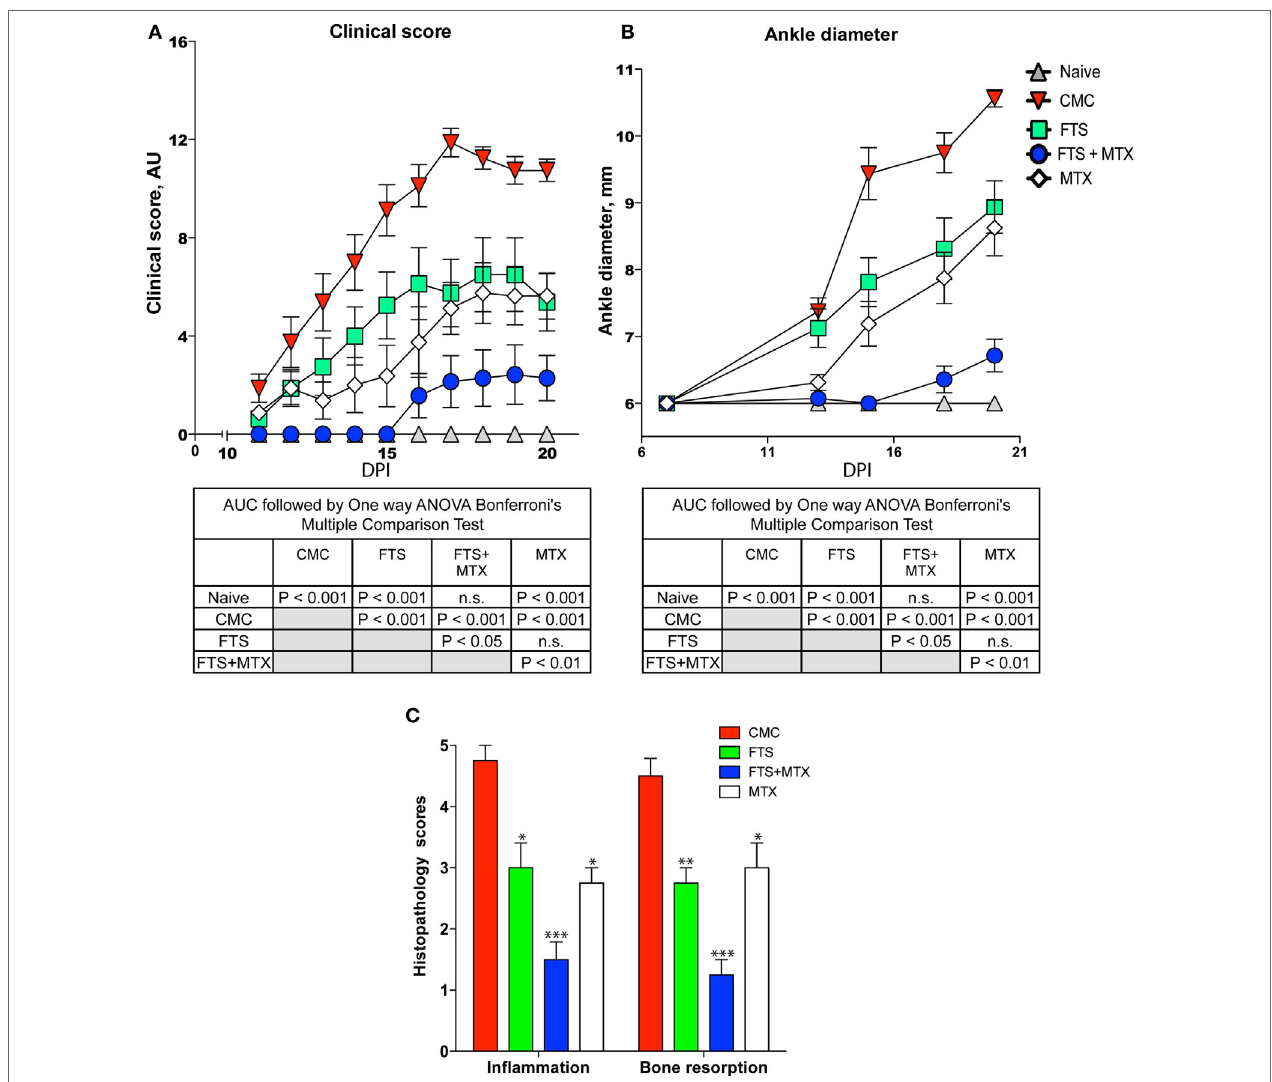
FigUre 1 | Farnesylthiosalicylic acid (FTS) treatment reduces the severity of adjuvant-induced arthritis. Rats were immunized with CFA and then graded regularly for signs of arthritis by a clinical disease severity score (a) , and by caliper measurements of ankle joint diameter (B) . Rats in the experimental arms were treated starting day + 1 with either oral FTS (100 mg/kg), 0.5% carboxymethyl cellulose (CMC) vehicle solution, weekly i.p injection of MTX (0.5 mg/kg), or FTS combined with MTX. Statistical analysis of the AUC of the effect of the various treatments on the clinical score (a) and ankle diameter (B) was done by one way ANOVA with post hoc Bonferroni’s multiple comparison test. The results of the analysis are summarized in the table inset. One representative of three independent experiments is depicted (* P ≤ 0.05, ** P ≤ 0.01, and *** P ≤ 0.001). (c) Tibiotarsal (ankle) joint tissue sections were stained with H&E for histopathological assessment, and scored on a scale of 0–5 for inflammation and bone resorption. The bar graph represents the quantification and statistical analysis of histopathology of ankles of arthritic rats in the various treatment arms. Shown bars from > 3 experiments performed with n = 8 rats in each treatment